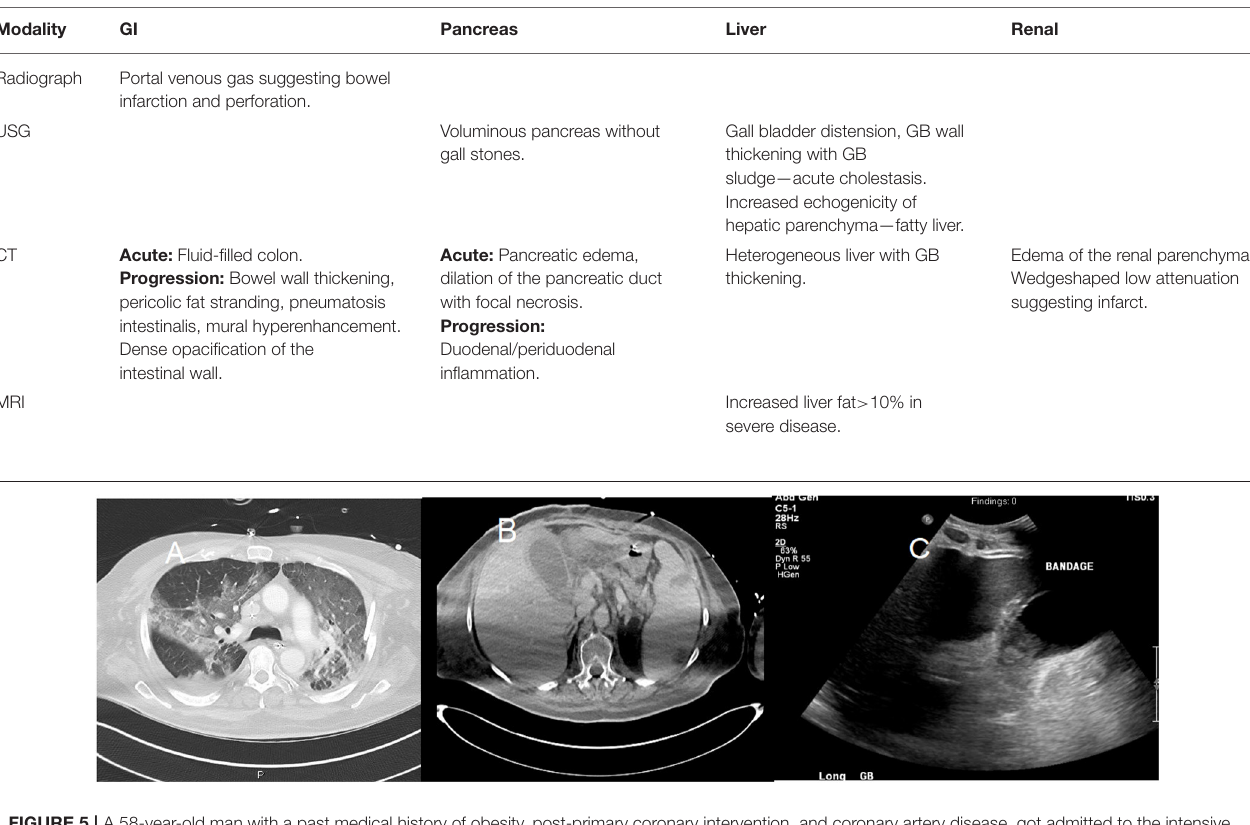
TABLE 4 | Abdominopelvic imaging features of COVID-19. Modality